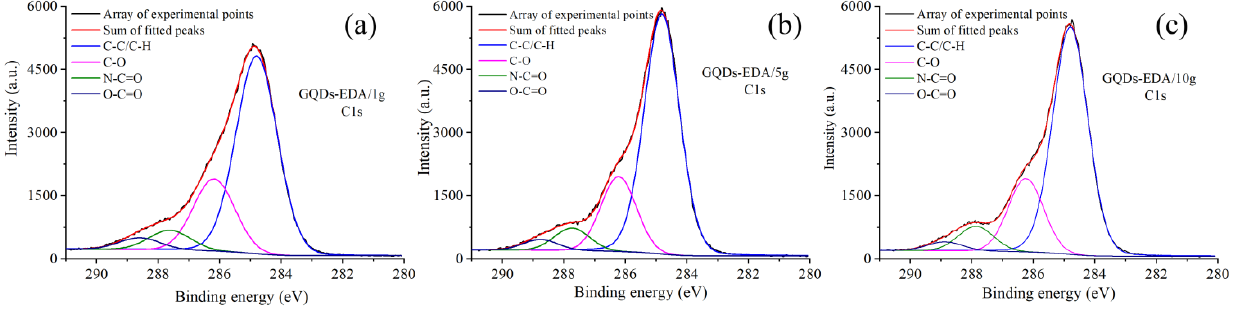
Figure 4. Analysis of high-resolution XPS spectra of C 1s region for samples GQDs-EDA/1 g ( a ), GQDs-EDA/5 g ( b ), and GQDs-EDA/10 g ( c ). Table 1. Atomic % of C, O, and N, and functional groups ratios in the samples p-GQDs, GQD-EDA/1 g, GQDs-EDA/5 g, and GQDs-EDA/10